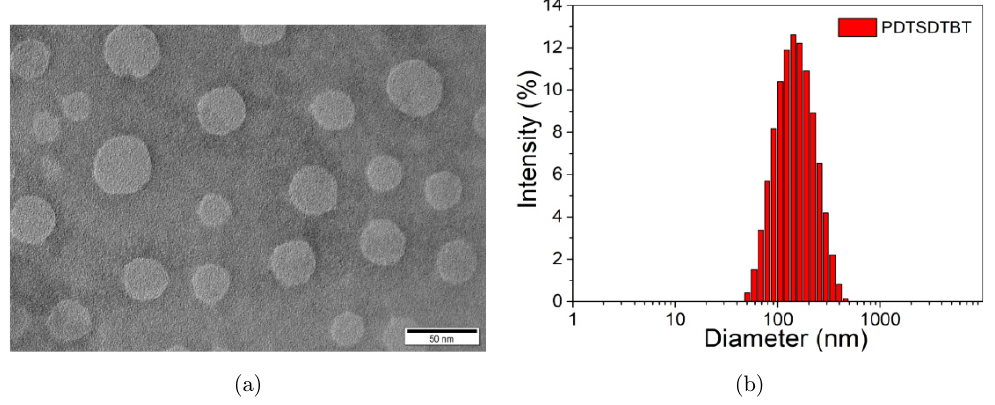
Fig. 2. (a) TEM image and (b) diameter distribution of PDTSDTBT